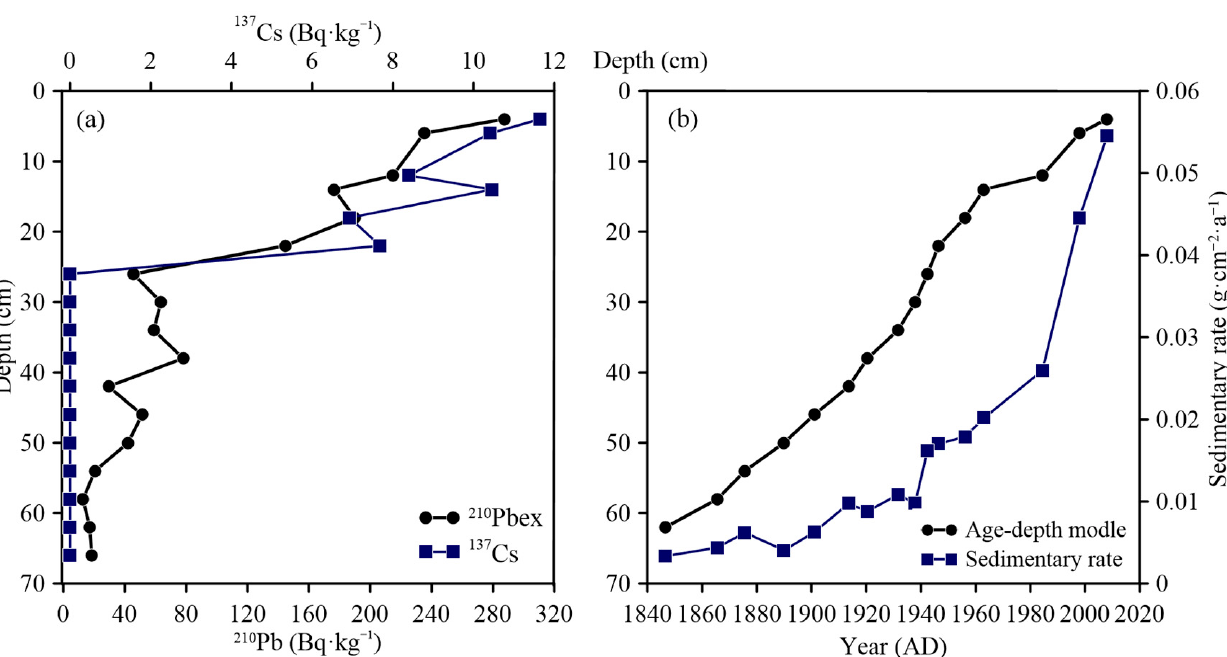
Figure 3. Dating results of the core from Huanggai Lake: ( a ) downcore variations in 137 Cs and 210 Pb ex activities; ( b ) age–depth model and sedimentary rates.